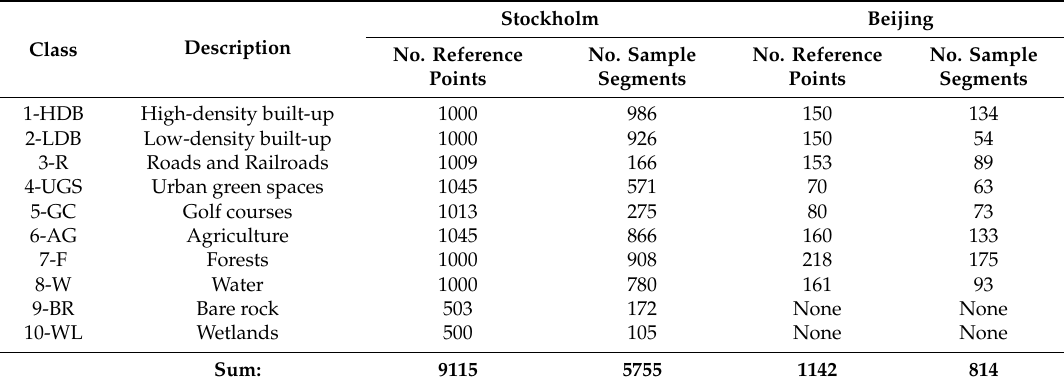
Table 1. Classification schema in Stockholm and Beijing.